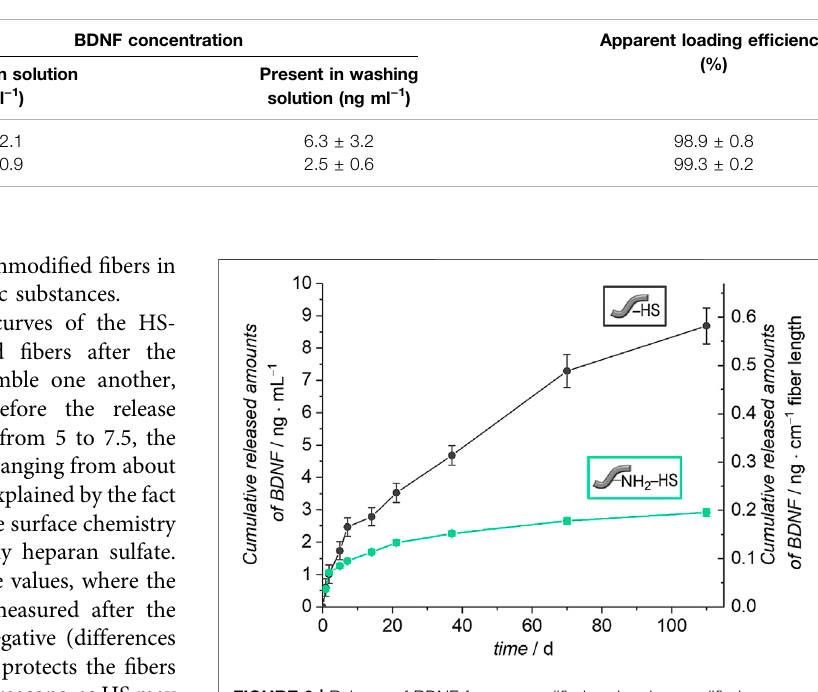
FIGURE 9 | Release of BDNF from unmodi fi ed and amino-modi fi ed fi bers pre-coated with heparan sulfate (HS) (PBS with 0.1% BSA, 110 days, 37 ° C). The left axis represents the cumulative BDNF release referred to 1 ml releasemediumandtherightaxisshowsthecumulativereleaseofBDNF with regard to 1 cm fi ber